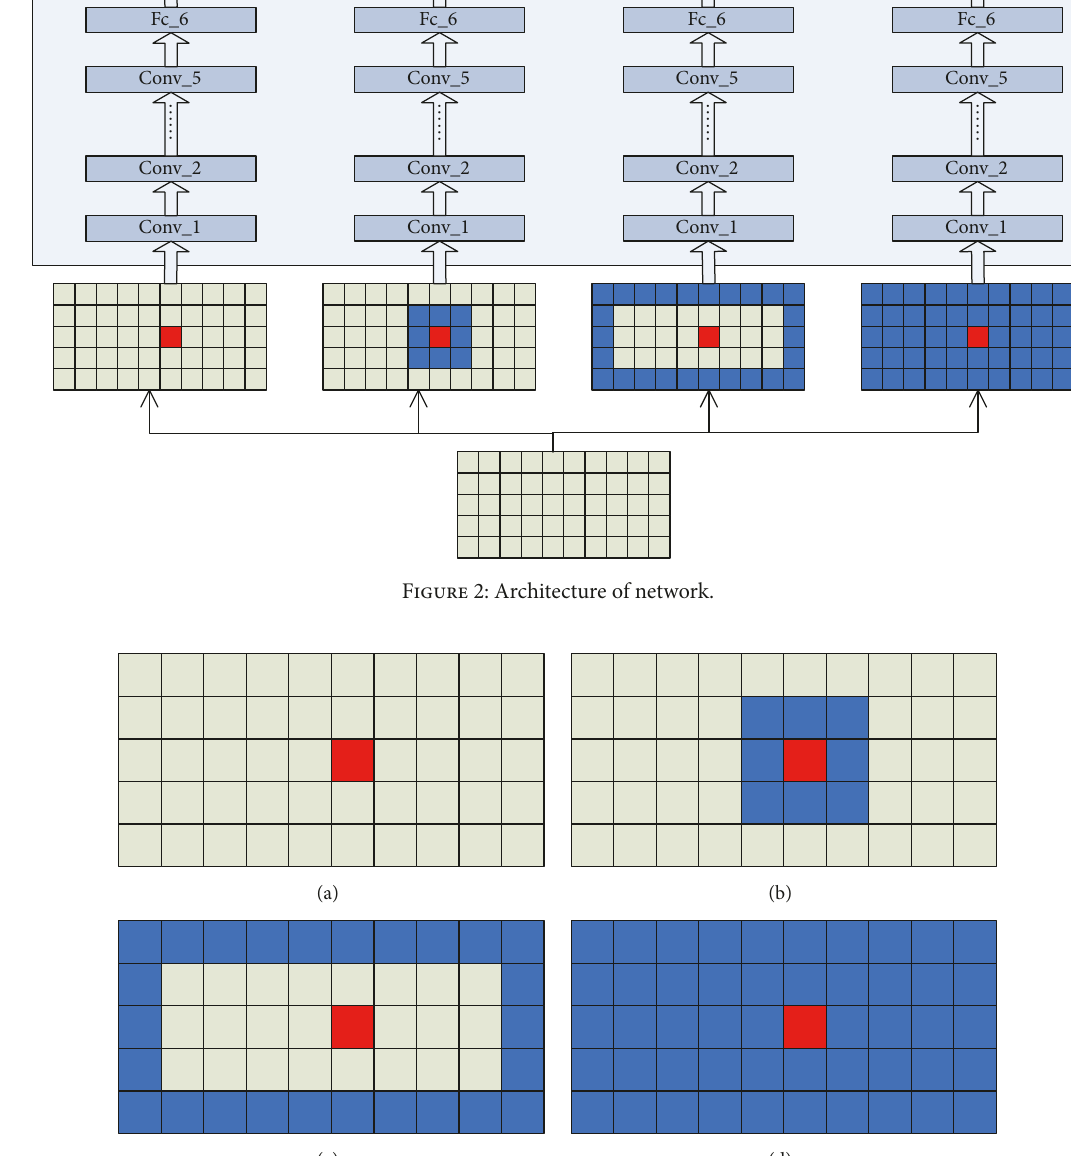
sample in a sliding window fashion; (2) neighborhoods of rectangle sample; (3) boundaries of the image; (4) image area except rectangle sample. Four types of regions are shown in Figure